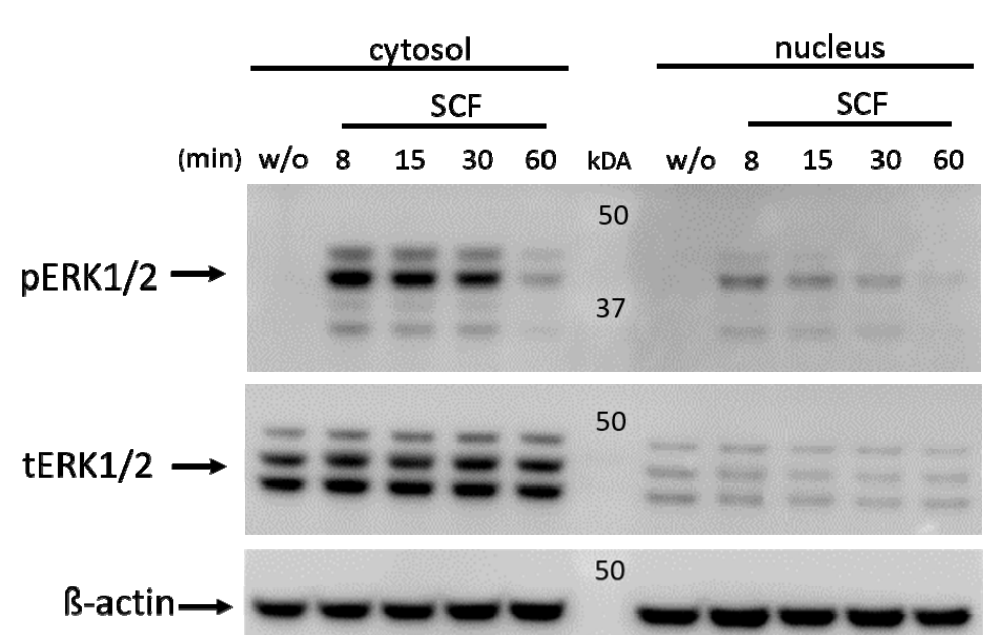
Figure 4. ERK1/2 is constitutively present in the cytoplasm and nucleus; activation-dependent phosphorylation is not associated with translocation. MCs were treated with SCF for the times given, cytosolic and nuclear fractions were prepared separately, and phospho-ERK1/2 (pERK1/2), as well as total ERK1/2 (tERK1/2), were detected by immunoblot. β -actin served as the loading control. One of three experiments with identical outcomes is shown. The same membrane as in Figure 3 is shown.